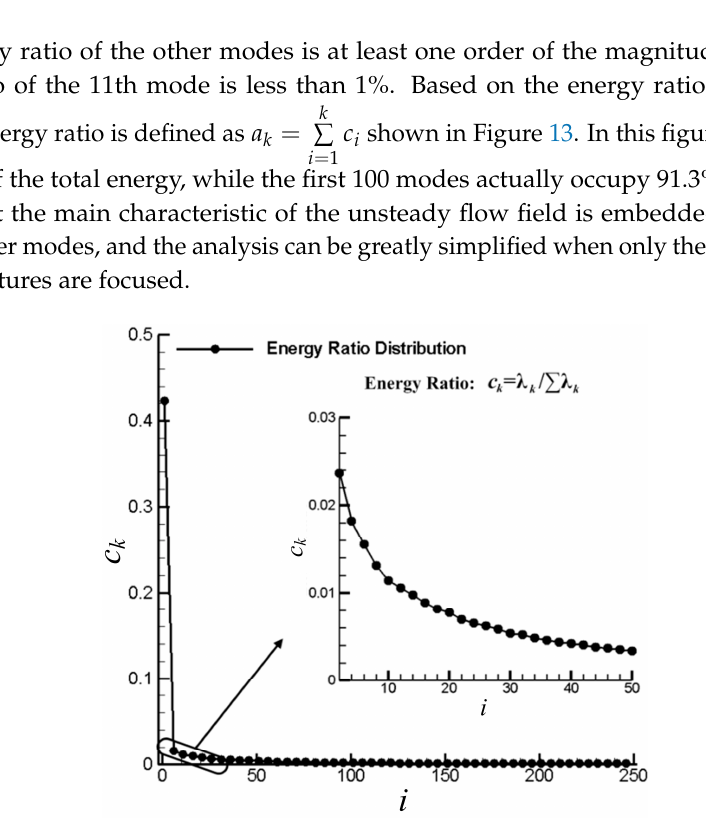
Figure 12. Energy ratio spectrum (energy ratio vs. rank).